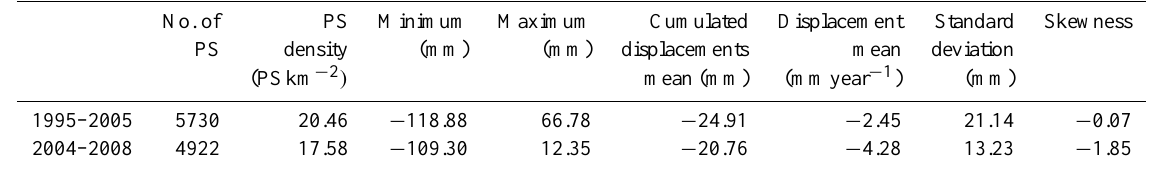
Table 3. Descriptive statistical measurements for both periods.